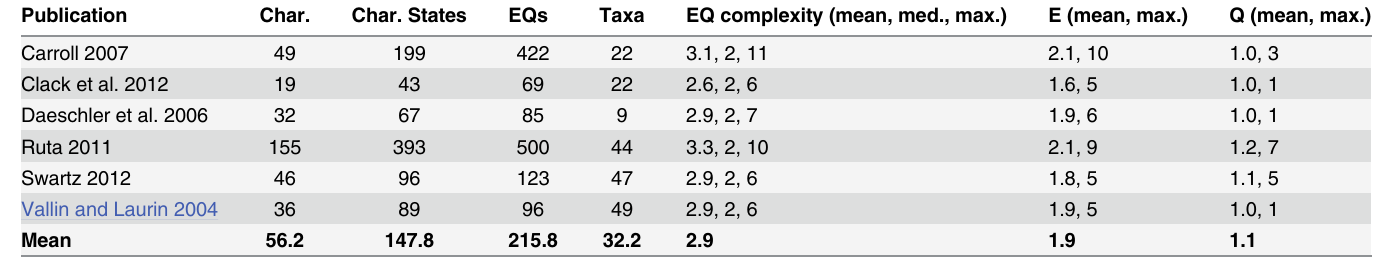
Table 3. Breakdown per matrix publication of the number of characters and states, limb/fin and girdle EQ annotations, taxa referenced in the limb/ fin and girdle section of the monograph, and the average EQ complexity (see Methods). Char. = Character; Char. States = Character States. Publication Char.